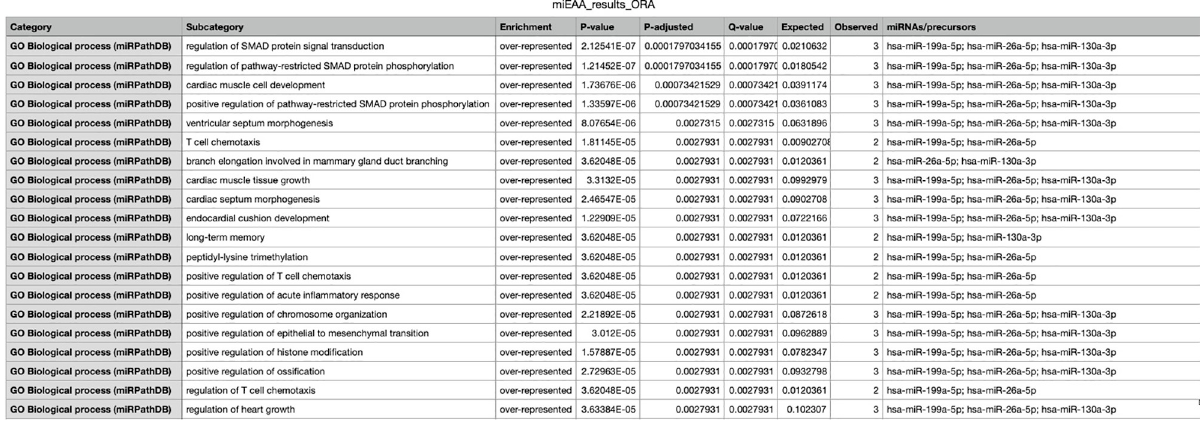
Fig 3. miRPathDB predicted biological process pathways for target